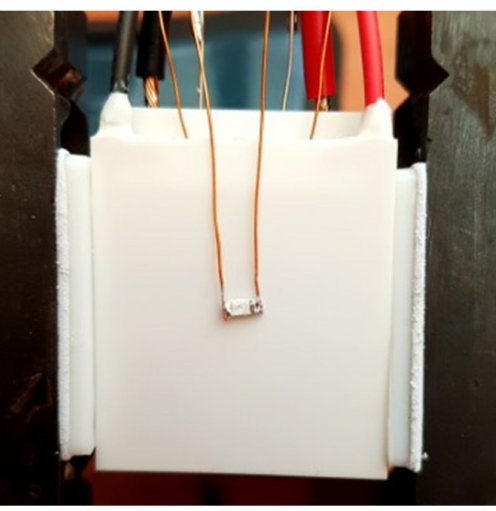
Figure 3. View of cooling system